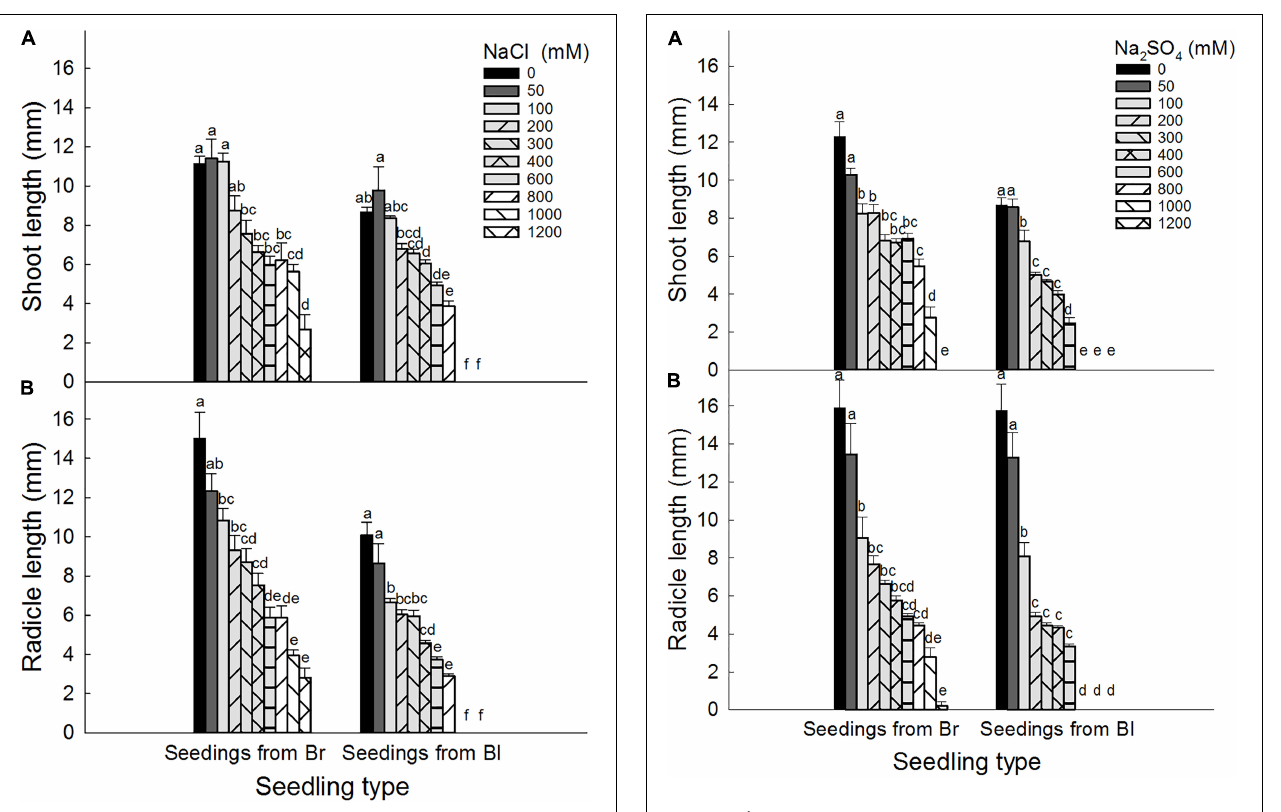
FIGURE 4 | Effect of NaCl on (A) shoot and (B) radicle length of seedlings grown from dimorphic seeds of S. salsa . Br, brown seeds; Bl, black seeds. For each treatment there were 10 biological replicates. Different lower-case letters indicate significant differences in shoot or radicle lengths of seedlings grown from each seed type.